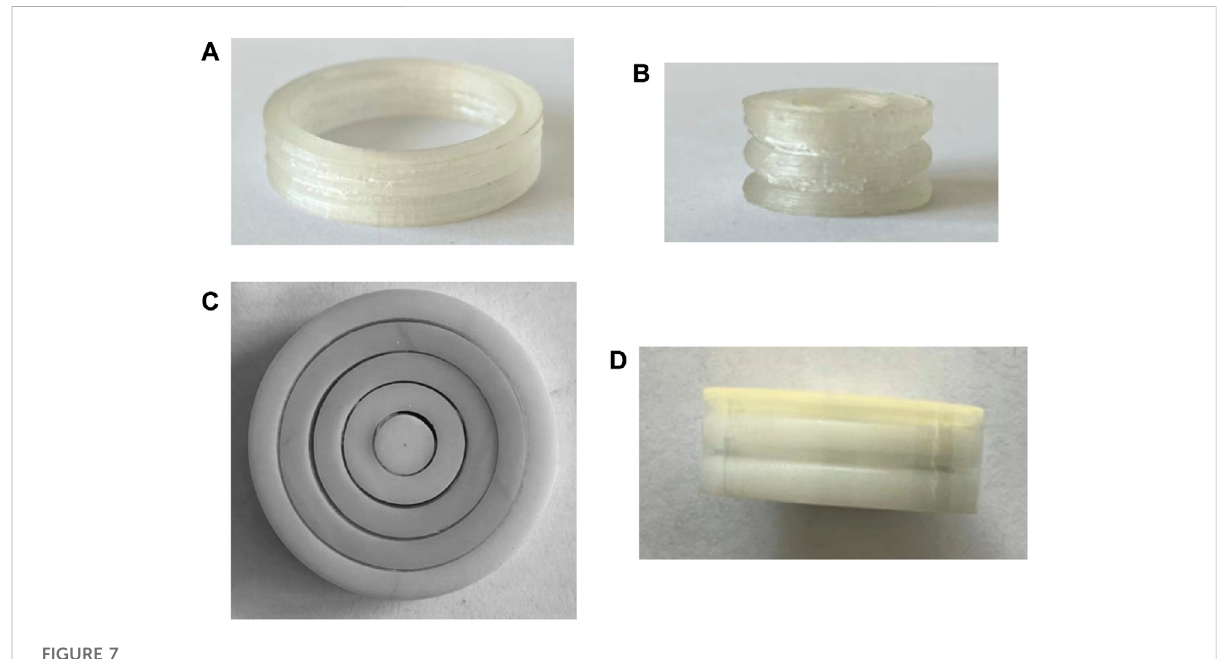
FIGURE 7 (A) DeformedMSLbyprintingasawholefromFDMwithPLA (B) CoarsesurfacefromFDMwithPLA (C) FinesurfacefromSLAwithUTR9000 (D) Fine surface protected by adhesive tapes during testing.